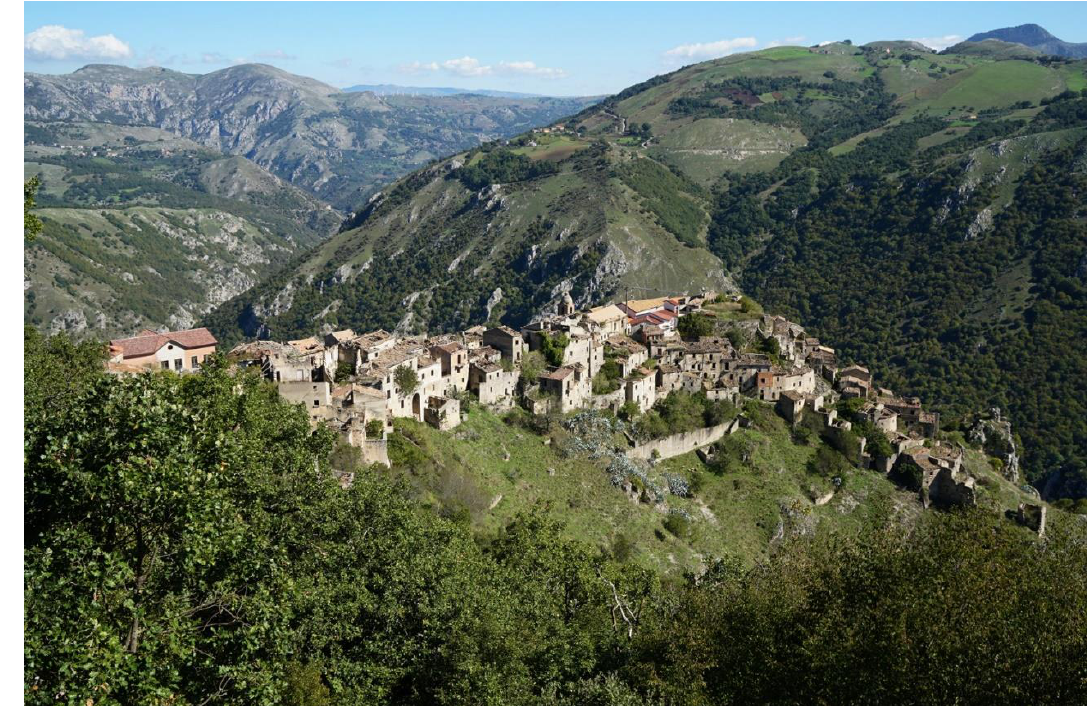
Figure 86. Romagnano al Monte: panoramic view of the village, completely abandoned after 1980 earthquake, now ghost town (photos by [35,36]).